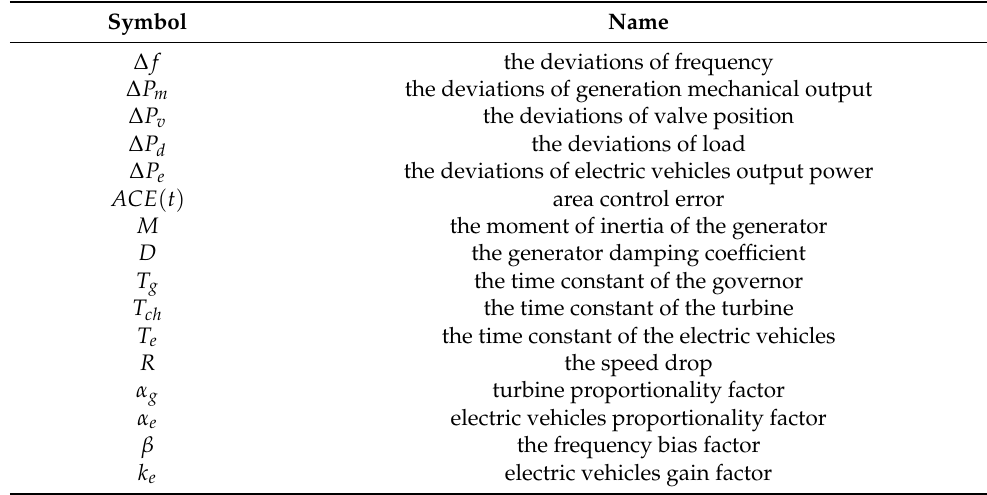
Table 1. Networked power systems parameters and their